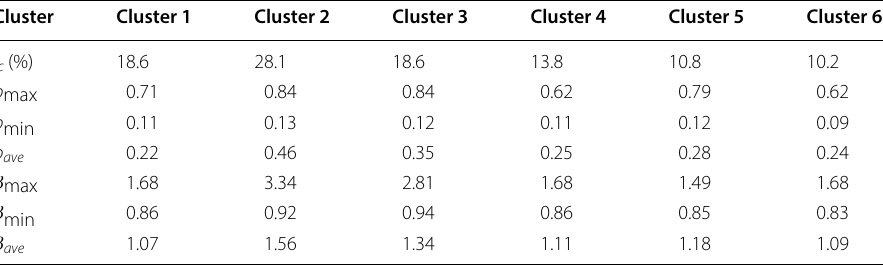
Table 5 Statistics of the clusters from Fig.